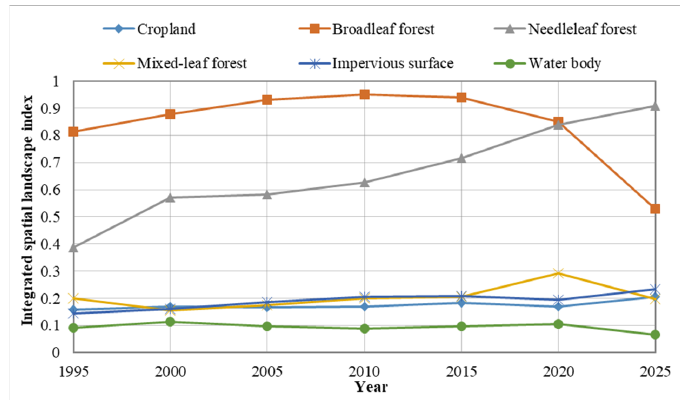
Figure 9. Results of ISLI for Di ff erent Land Cover Types from 1995 to 2025.